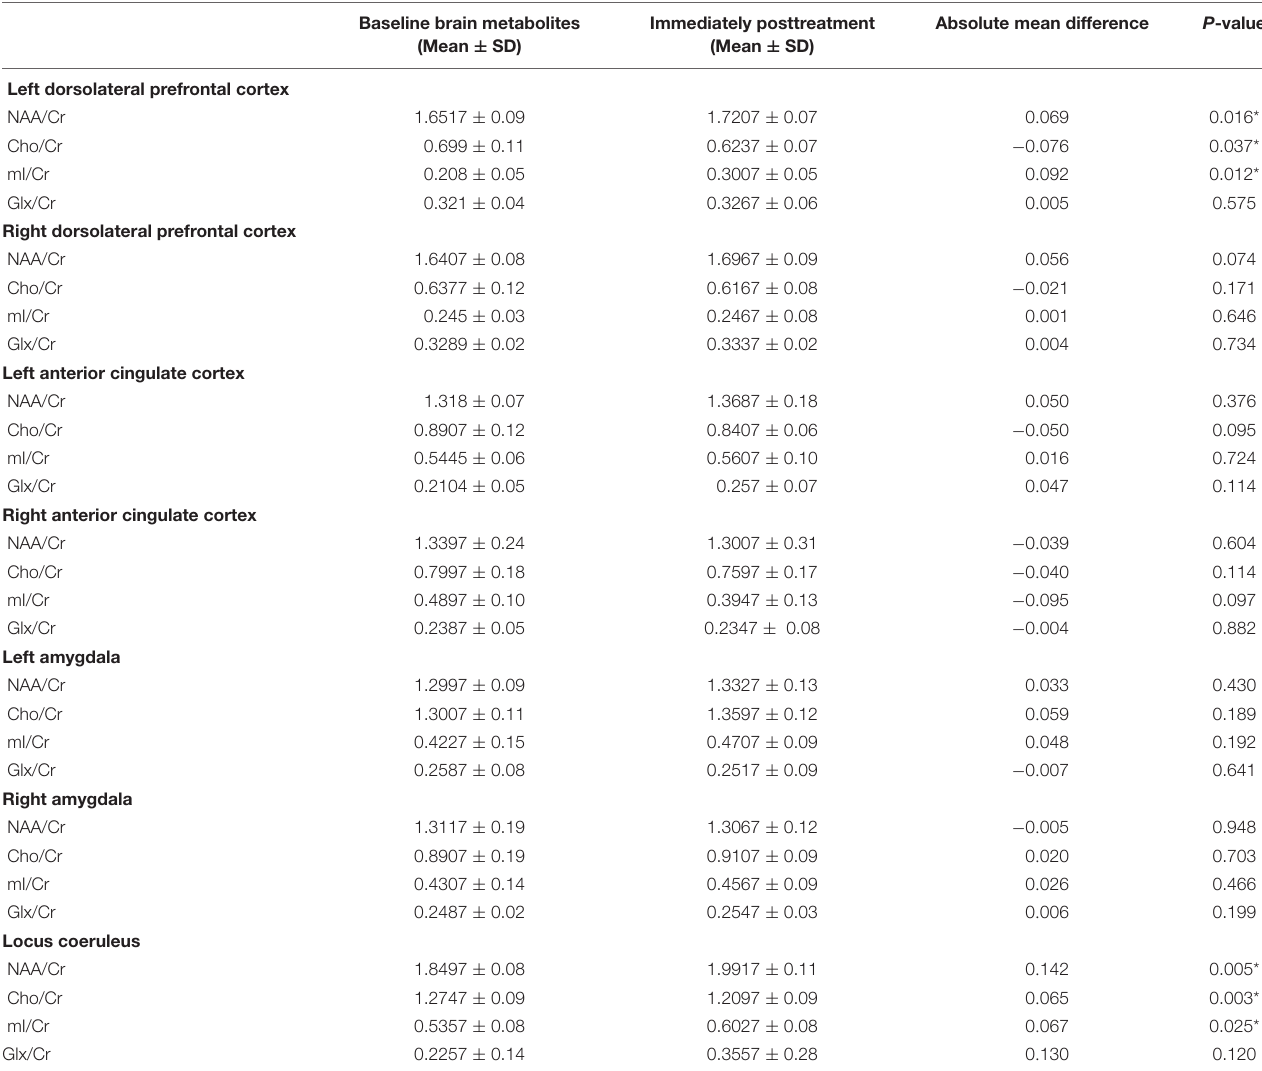
TABLE 3 | Metabolites concentration in the areas of interest at baseline and immediately posttreatment ( n =